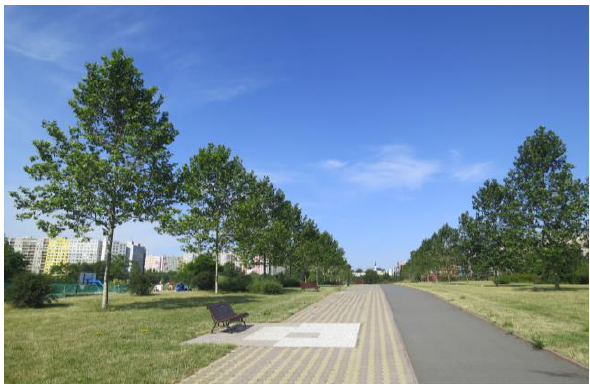
Fig. 1. The Avenue of Celebrities in European Street in Prague 6. Fig. 2. On European Day in Prague on the 9 th of May 2000, The avenue is lined with 90 plane trees planted on the 4th of the 50th anniversary of the signing of the so-called Schumann September 2010 as part of the 90th anniversary celebrations Declaration between France and Germany, Lime Trees for Europe of Prague 6. The London plane trees were named after significant were planted. The Declaration is considered to be the beginning people who lived in Prague 6 or had a connection through of European integration efforts. Lime Trees for Europe can be their work ( A. Rudl , 2018) found in the Hostivar and Chodov localities ( A. Rudl , 2018)